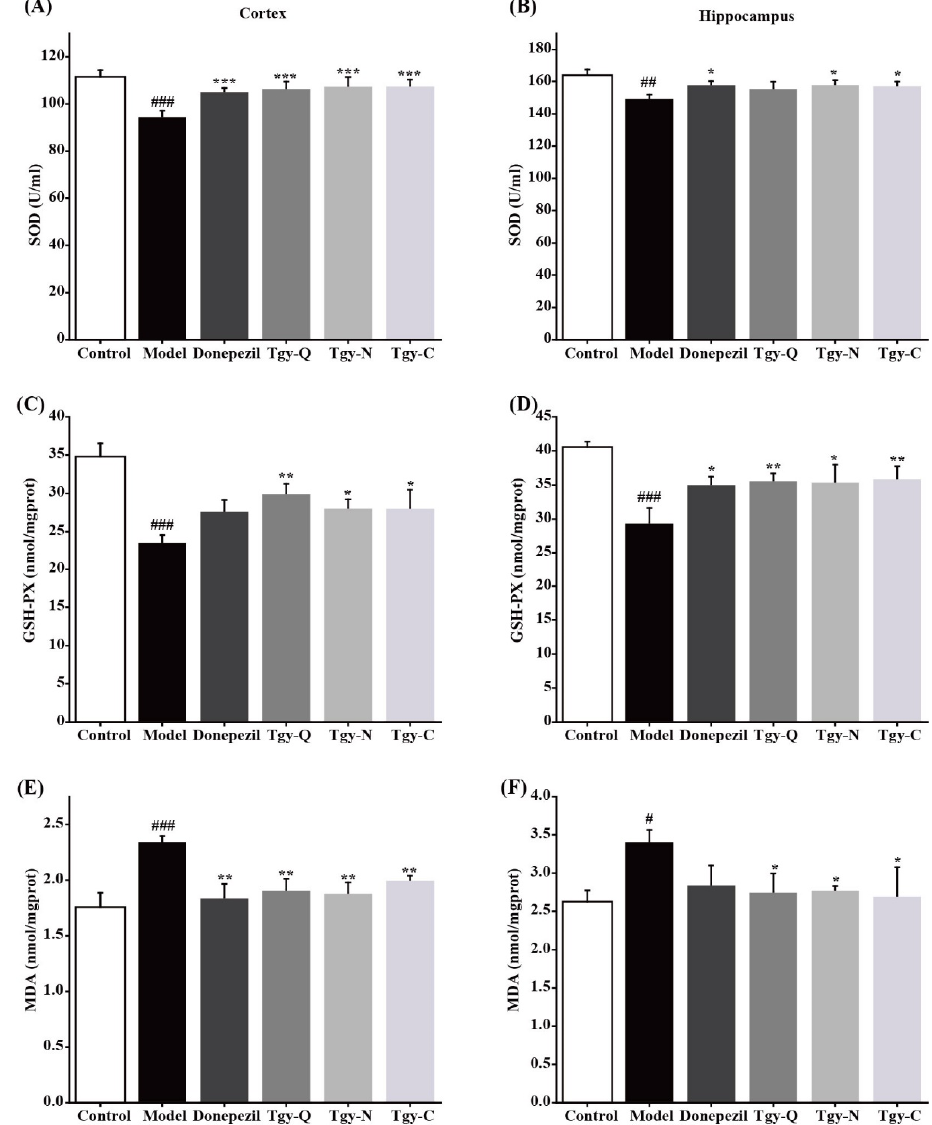
Figure 6. Anti-oxidative abilities of Tieguanyin tea extracts on cortex and hippocampus of mice in dif- ferent groups. ( A , C , E ) Changes of SOD, GSH-PX, and MDA in cortex. ( B , D , F ) Changes of SOD, GSH-PX, and MDA in hippocampus) (Control group n = 7, n = 5 for each other group). # p < 0.05, ## p < 0.01, and ### p < 0.001 different from control group. * p < 0.05, ** p < 0.01, and *** p < 0.001 different from model group.